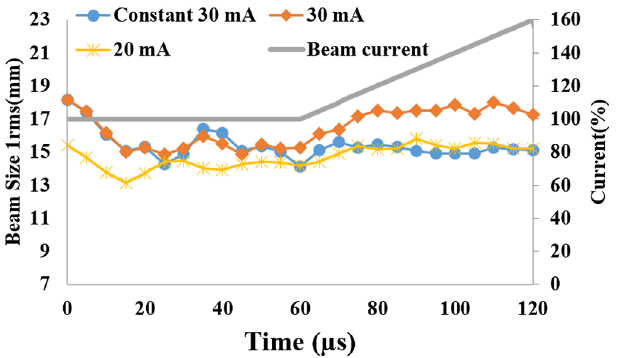
FIG. 10. Beam pulses taken to simulate beam intensity insta- bilities instead of constant current.